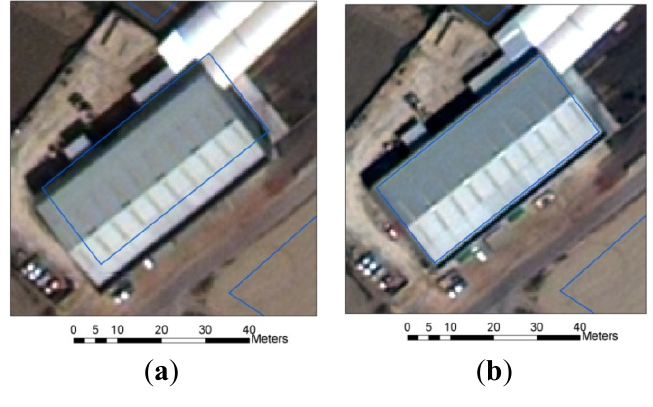
Figure 6. Pan-sharpened orthoimages showing an industrial white building. ( a )